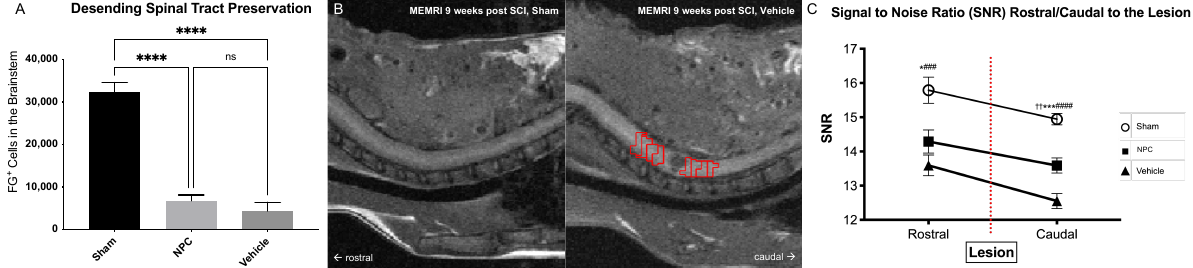
Figure 3. Preservation or regeneration of descending and ascending spinal tracts in the injured spinal cord eight weeks after severe SCI. ( A ) The number of FG + neurons in the brainstem and thus possibly the extent of descending reticulospinal tract preservation or regeneration was not significantly different between NPC animals (group 1) and Vehicle animals (group 2; n = 5 animals per group; one-way ANOVA with post-hoc Tukey-HSD-test; p = 0.6452). ( B ) On the left side, sagittal T1-weighted MEMRI image of an uninjured Sham animal (group 3) eight weeks after SCI and 48 h after intrathecal injection of MnCl 2 , showing faint but nearly homogeneous contrast enhancement of the cervicothoracic spinal cord. On the right side, sagittal T1-weighted MEMRI image of an injured Vehicle animal (group 2) depicting the lesion as a round, hypointense formation in the cervical spinal cord with suspected caudal decrease of Mn 2+ signal intensity. Red ROIs depicting the axial slices from 4 mm rostral to 4 mm caudal to the lesion used for detailed SNR measurements. ( C ) Rostral to caudal decrease of SNR over the lesion was only significant in the Vehicle group ( n = 5 animals, n = 4 rostral and n = 4 caudal axial slices per animal; unpaired two-sample t -test, p = 0.007). Correspondingly, SNR caudal to the lesion was significantly lower in Vehicle animals compared to NPC and Sham animals ( n = 5 animals per group, n = 4 caudal axial slices per animal; one-way ANOVA with Tukey-HSD-test; p = 0.0017 and p < 0.0001, respectively), indicating more preserved or regenerated descending as well as ascending spinal tracts after NPC-transplantation (* p < 0.05, NPC vs. Sham; *** p < 0.001, NPC vs. Sham; **** p < 0.0001, Vehicle vs. Sham and NPC vs. Sham; ### p < 0.01, Vehicle vs. Sham; #### p < 0.0001, Vehicle vs. Sham; †† p < 0.001, NPC vs. Vehicle; ns = not